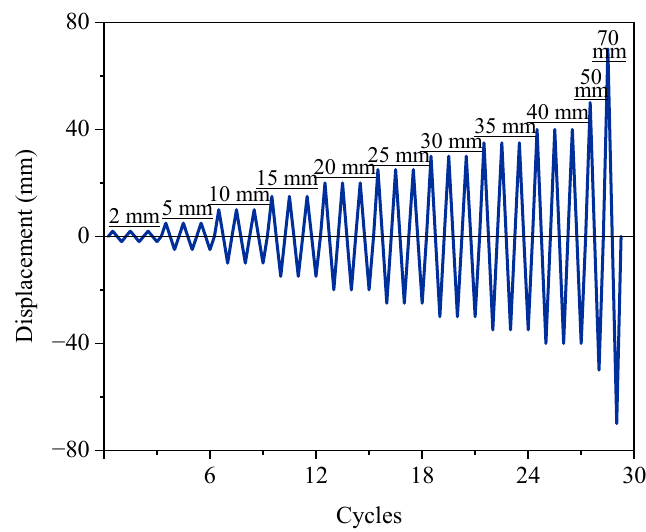
Figure 7. The protocol of the cyclic displacement-control load.